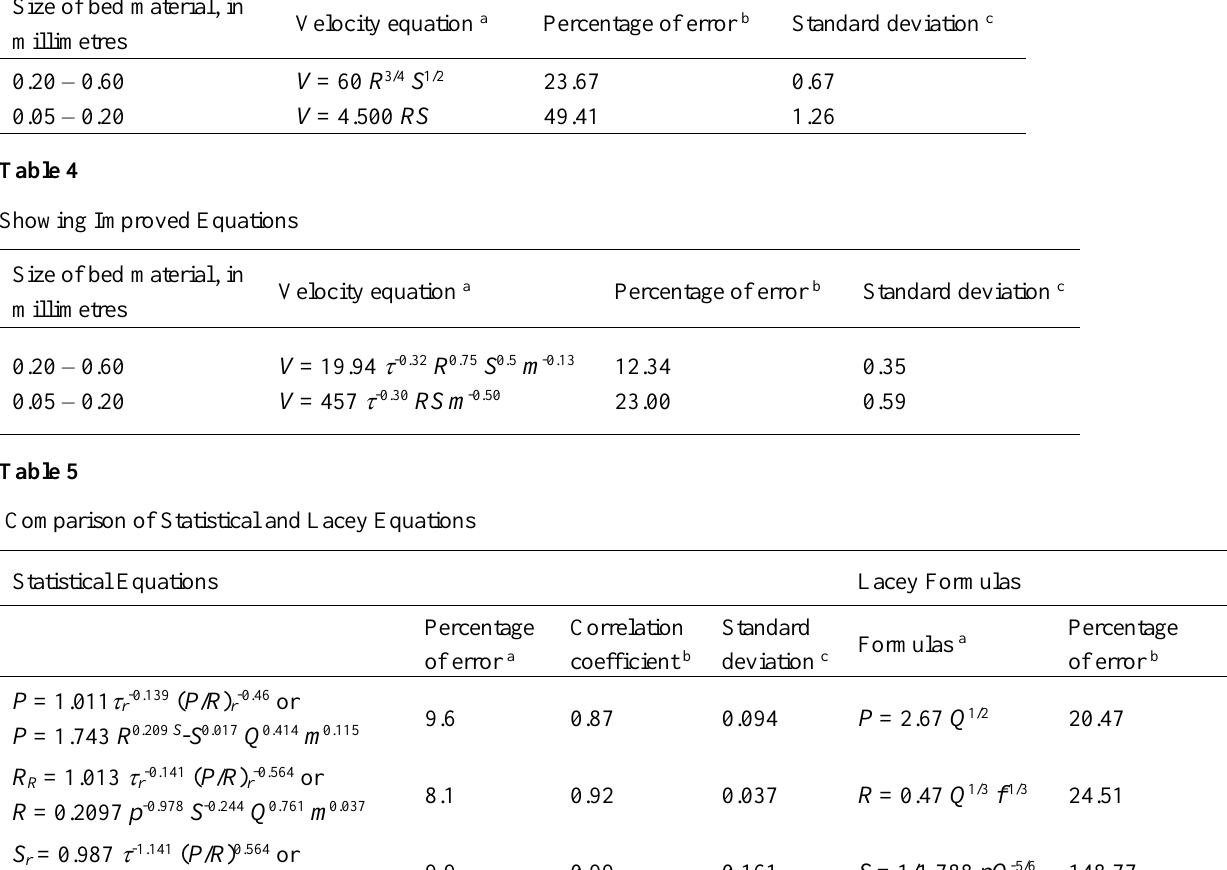
Percentages of Errors and Standard Deviations Size of bed material, in